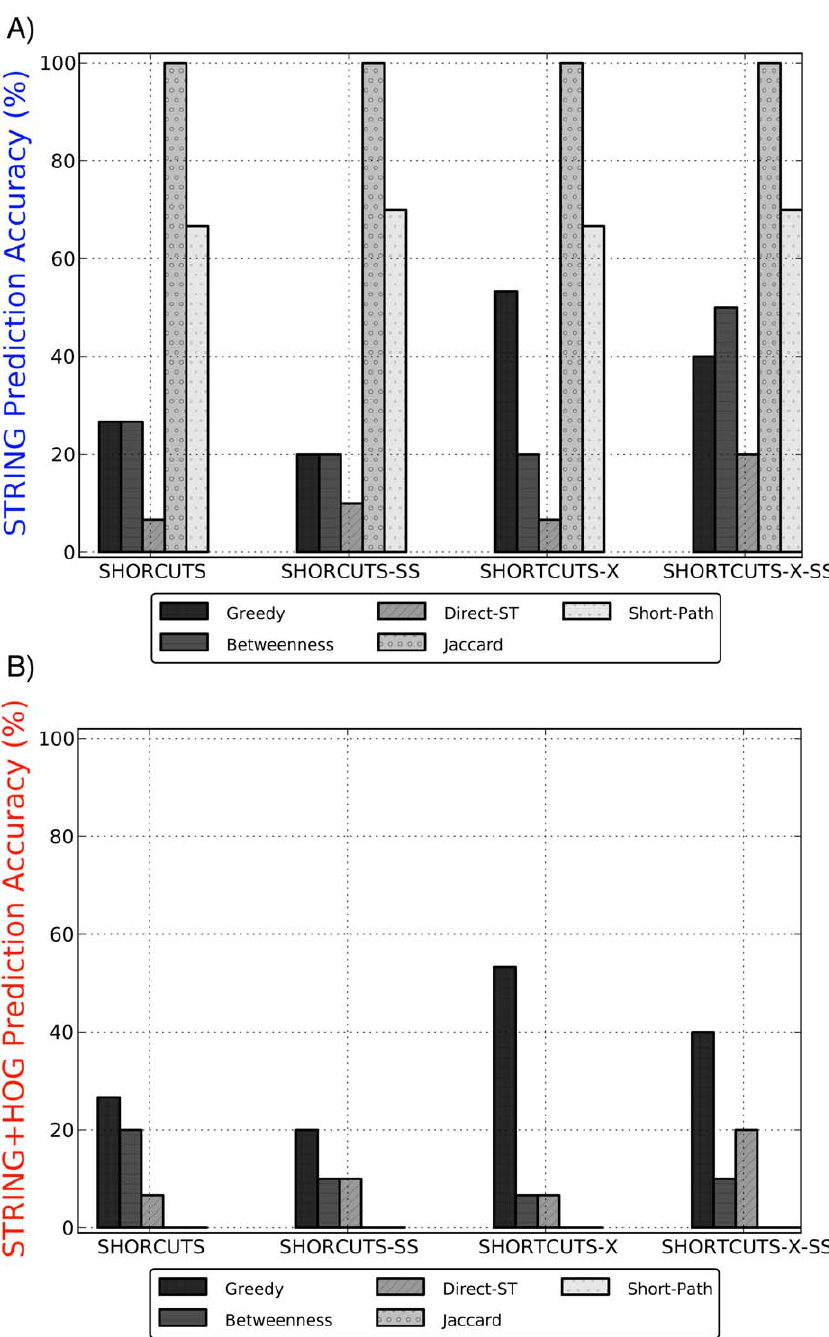
Figure 3. The prediction accuracy of the five methods for each objective function. We evaluated the top 15 (S HORTCUTS and S HORTCUTS -X) or 10 (S HORTCUTS -SS and S HORTCUTS -X-SS) predictions for each algorithm, after which the Greedy algorithm had reduced the objective function to nearly zero. The y { axis shows the prediction accuracy, defined as the percentage of predictions (from amongst all & 20 million possible missing edges) that lied within the set of A) STRING potential edges, and B) STRING potential edges that also connected known HOG-related proteins. The global methods (Jaccard and Short-Path) make accurate predictions when not constrained to be HOG-relevant. The Greedy algorithm outperforms all methods in making high quality predictions that connect HOG proteins.